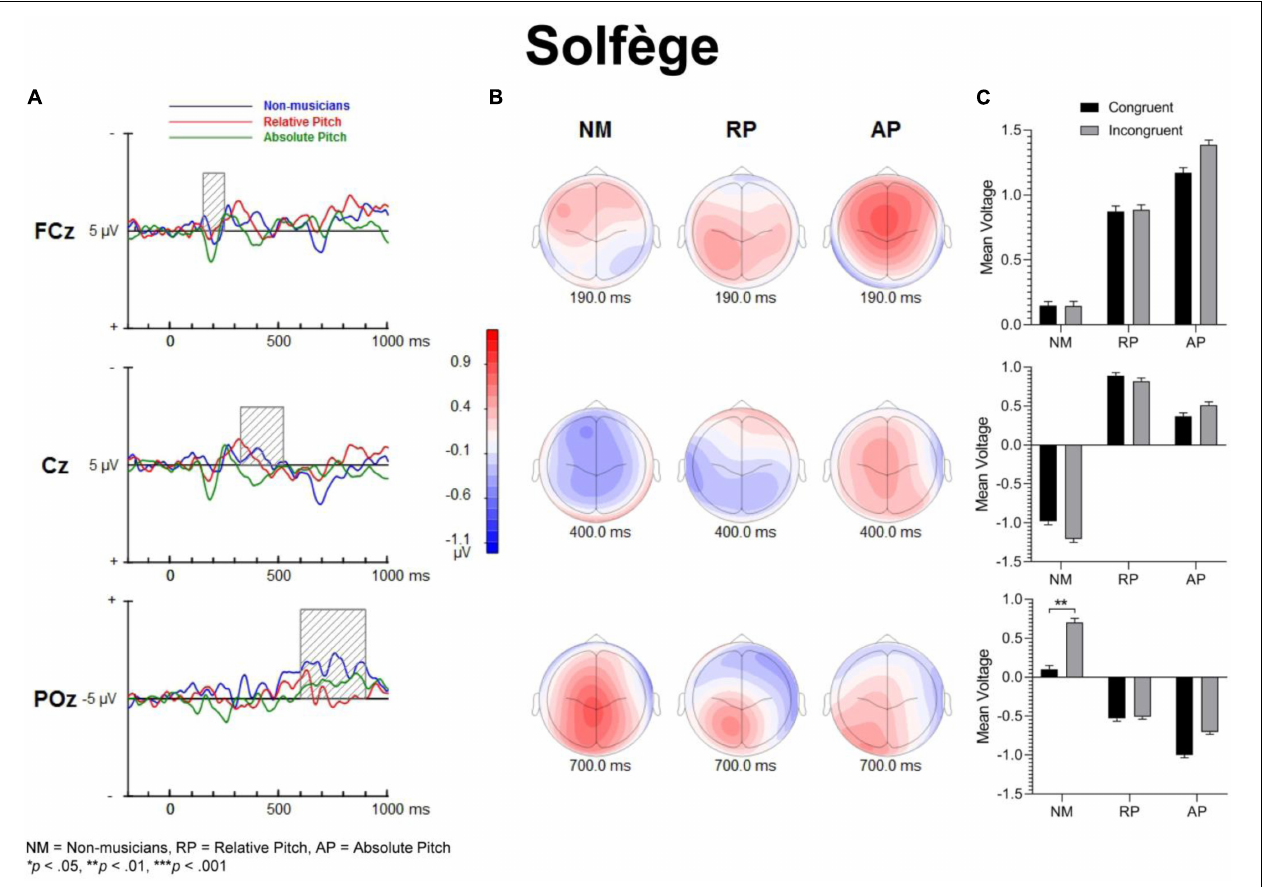
FIGURE 6 | Event-related potential difference waveforms of incongruent minus congruent conditions and topographic maps. The solfège task does not necessarily evoke a strong inhibitory response, though the non-musicians have a post-trial positivity in their LPC potentials. (A) Difference waveforms and shaded areas displaying temporal windows of interest. (B) Topographic maps show difference dipoles at 190 and 400 ms along with a posterior positivity at 700 ms post-stimulation, which occur within the temporal windows of interest. (C) Bar graphs showing group mean event-related potential amplitude for the P200 (top panel), N450 (middle panel) and LPC (bottom